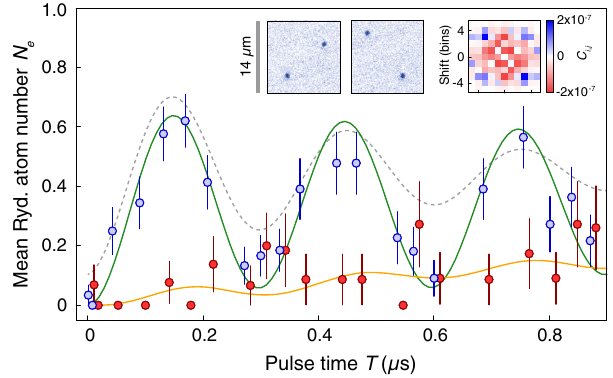
FIG. 5. Breakdown of the blockade. Measurement of the collective Rabi oscillation in a sample with N ¼ 185 ð 8 Þ atoms. (a) The contribution of states with n ¼ 2 (red points, shifted slightly horizontally for better vis- n e ibility) agrees with the theoretical calculation (green and orange solid lines, scaled by extracted detection efficiency η ). For comparison, we show the fit (gray line) to the mean (see Fig. 2), which shows twice faster dephasing than the n alone. We have chosen the simplest possible fitting model with a constant offset such that the increasing fraction of double excitation results in a upward shift of the fit for small times. The inset shows two exemplary single shots with n FIG. 4. Superatom Ramsey spectroscopy. Evolution of the of view 14 × 14 μ m 2 , indicated by gray bar) and the two- mean Rydberg atom number N (blue points) versus hold time e T dimensional pair-correlation function C between the two π = 2 pulses (schematic in the inset) and R Color scale: red (anticorrelation) to blue (correlation). Data sinusoidal fit with Gaussian decay (gray line) for an initial sample binned 4 × 4 sites. All error bars are s.e.m. size of N ¼ 38 ð 3 Þ atoms. All error bars are